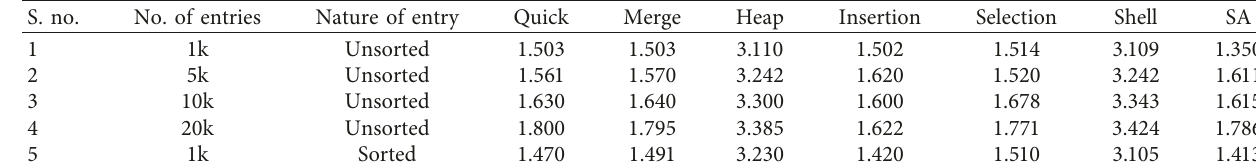
Table 2: Comparison of memory used in